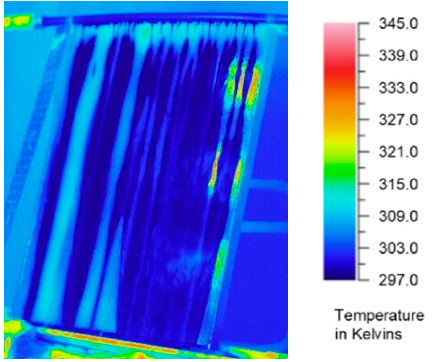
Figure 10. Temperature distribution on the front side of the 50 Wp PV panel after 15 min of the experiment (when dedicated water cooling system was used).